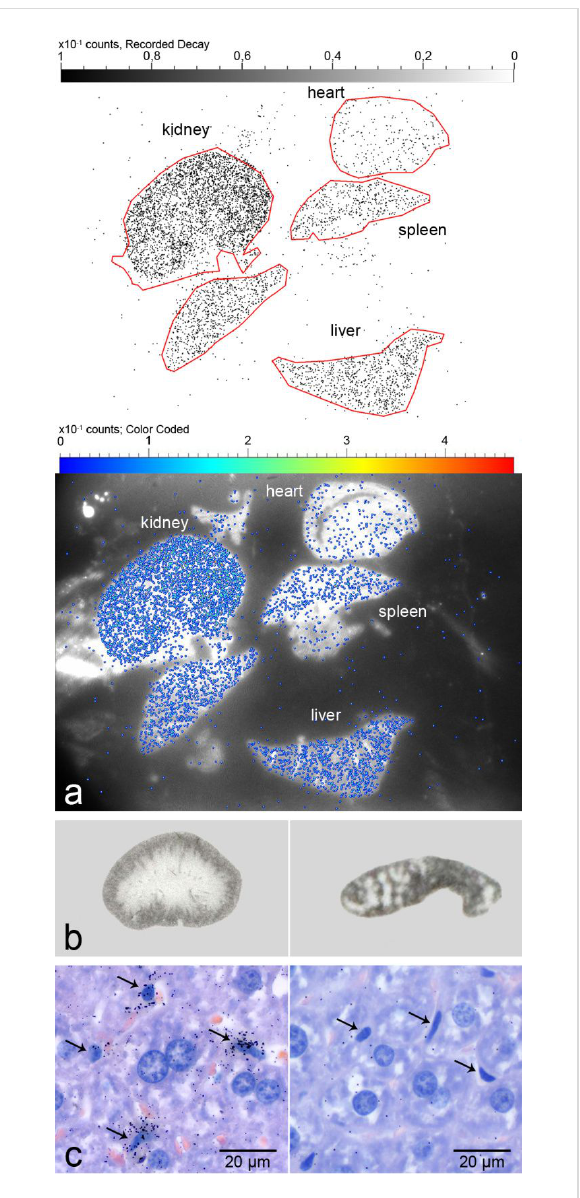
Figure 2: Autoradiographic detection of radiolabeled dPG 35 S amine in organs and tissues. (a) Semiquantitative micro imager analysis detected different amounts of dPG 35 S amine in mouse organs, decreasing from the kidney over the liver and the spleen to the heart one hour after intravenous injection (top panel: counting rates with regions of interest (indicated by red lines); bottom panel: combination of optical image and counting rates). (b) Single organ autoradiography of mouse kidney (left panel) and spleen sections (right panel) on X-ray film following dPG 35 S amine application identified distribution patterns of the radiolabeled NP in accordance with organ specific functional structure. In the kidney, NP were localized within the renal cortex (outer rim) whereas in the spleen they were clearly associated with the red pulp but not within lymphoid follicles (spared dots). (c) Light micro- scopic autoradiography with numerous radioactive decay-induced signals over Kupffer cells (arrows) in the liver of a mouse (left panel). Signals were sparse in adjacent hepatocytes with larger, more round nuclei. No signals were observed when unlabeled dPGS amine was used under otherwise identical experimental conditions (right panel). Hematoxylin and eosin-stained FFPE tissue sections.